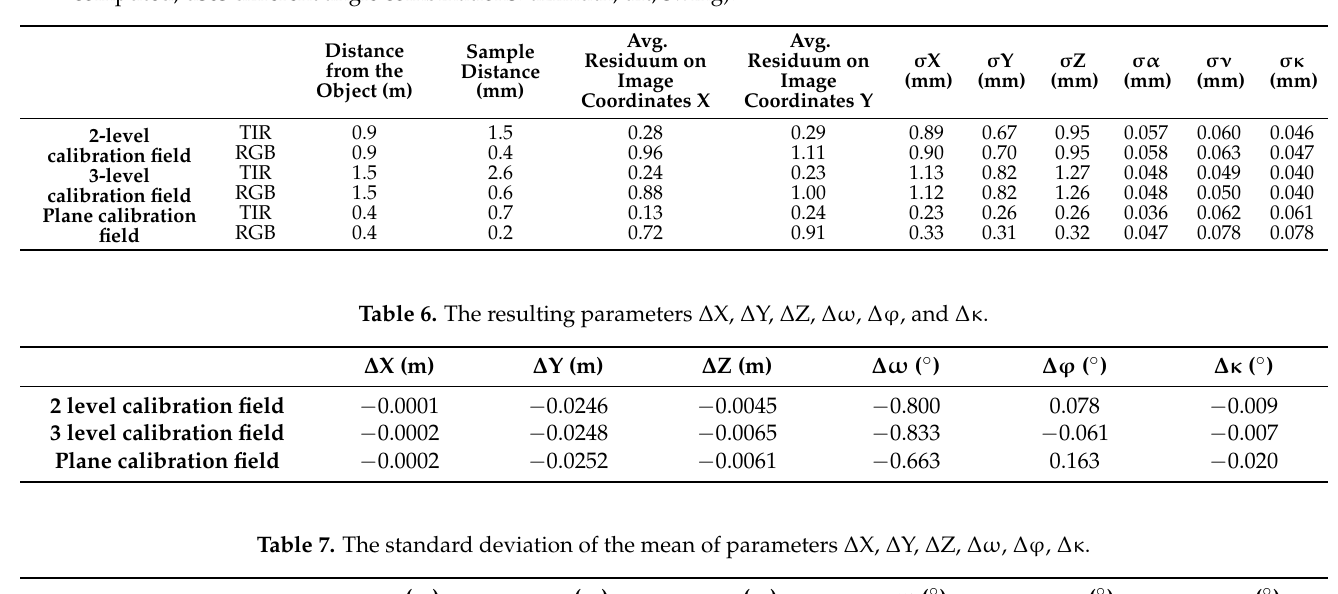
Table 5. Parameters and results of the bundle adjustment. (The software that was used, where the bundle adjustment was computed, uses different angle combinations: azimuth, tilt, swing).